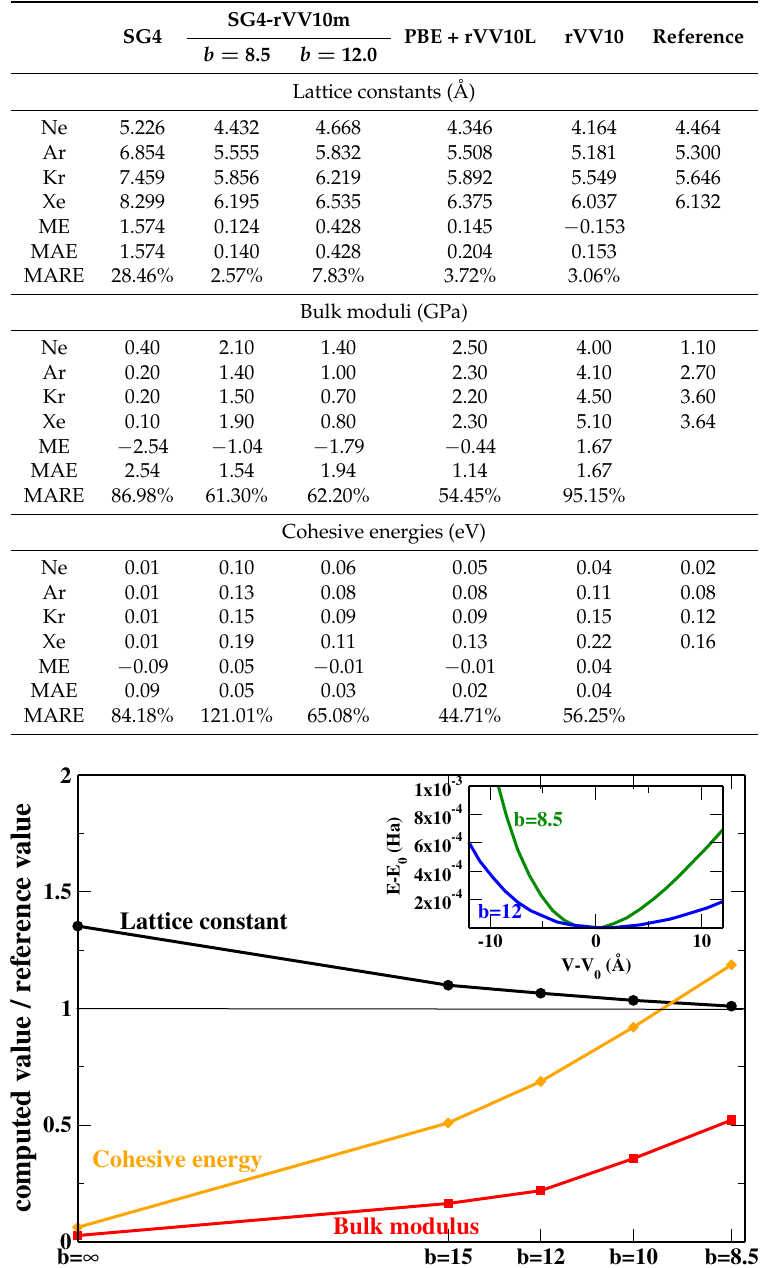
Table 1. Lattice constants, bulk moduli, and cohesive energies of the NOB4 test set as obtained with different functionals. The reference values are taken from Reference [63]. For each property, we also report the mean error (ME), the mean absolute error (MAE), and the mean absolute relative error (MARE).